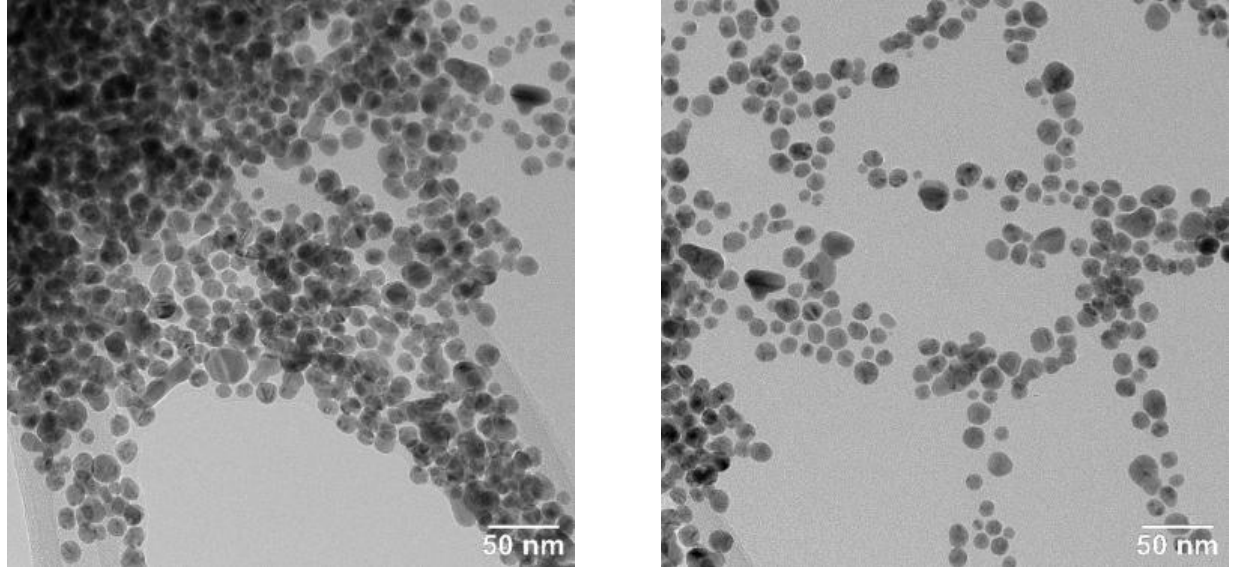
Figure 6. TEM images from different areas of the sample, showing spherical and quasi-spherical AgNPs.